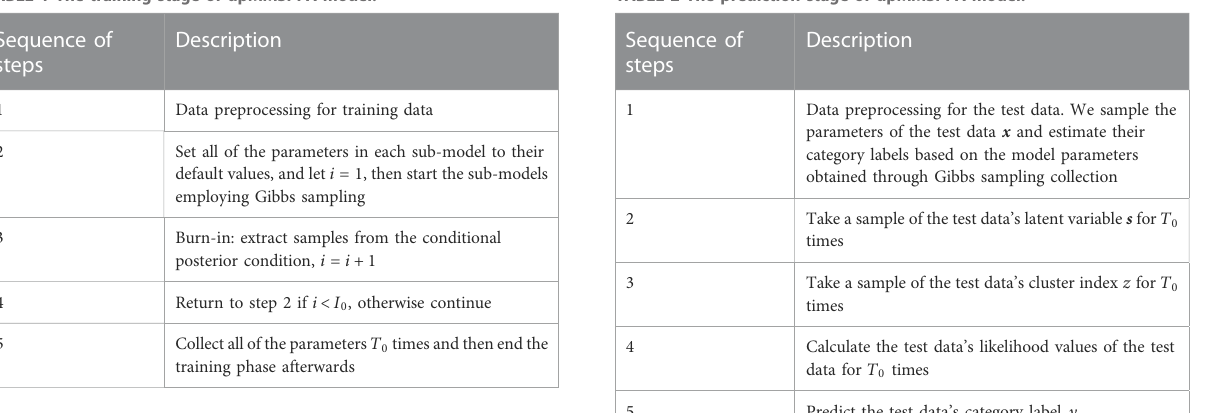
TABLE 1 The training stage of dpMMSPFA model. TABLE 2 The prediction stage of dpMMSPFA